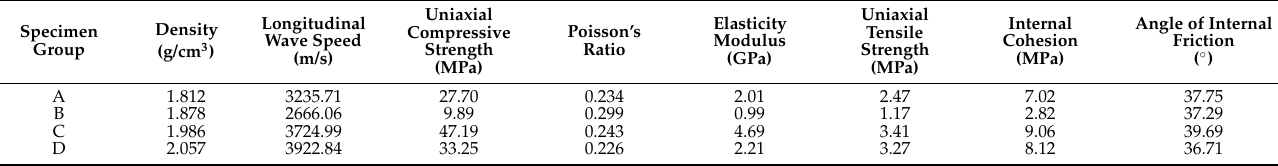
Table 3. Mechanical parameters.